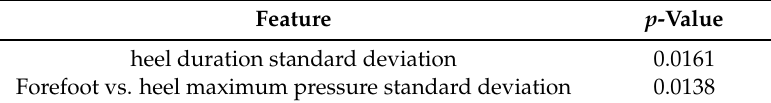
Table 5. T -test results.